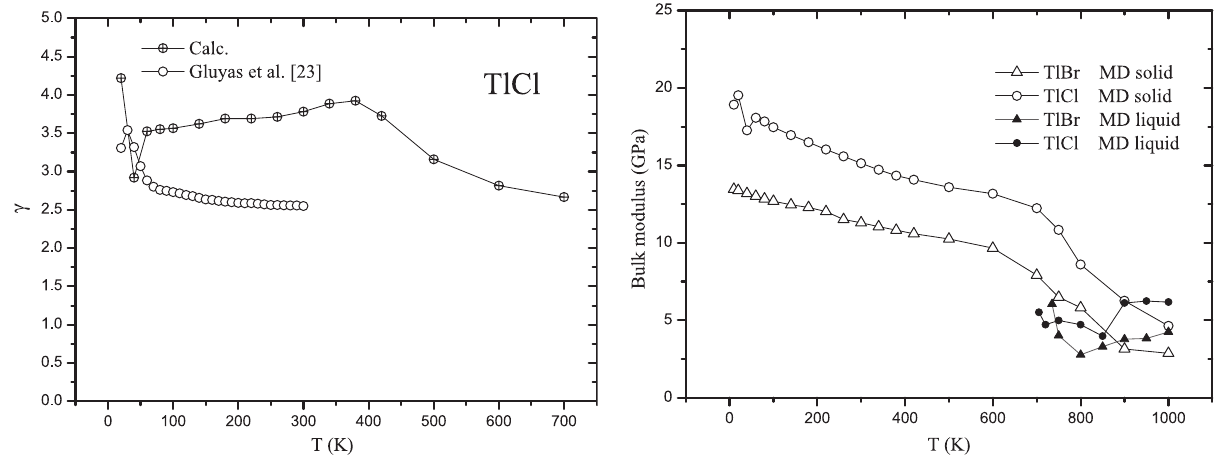
Fig. 7: The Grüneisen constant γ for TlCl. Fig. 8: The variation of bulk modulus with temperature for TlBr and